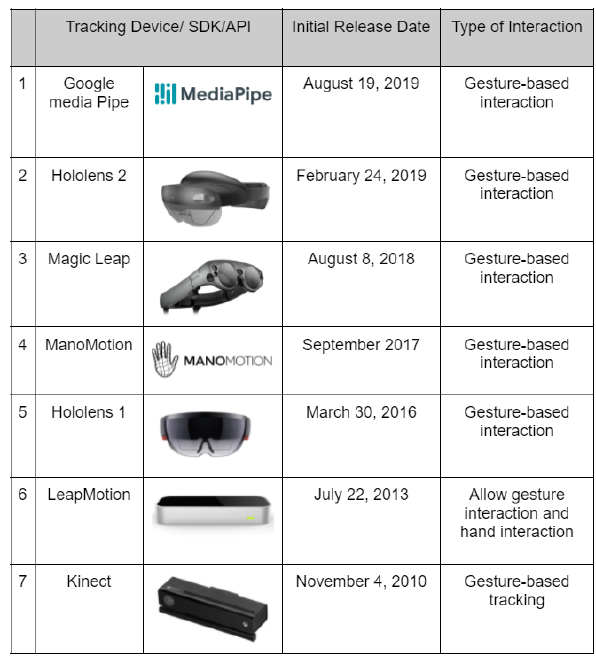
Figure 8. Devices/APIs used in AR for interaction to allow hand tracking and